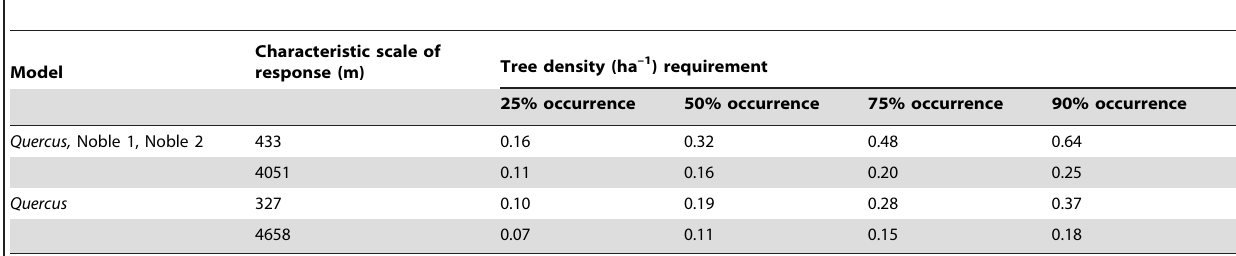
Table 2. Tree density required for 25%, 50% 75% and 90% probability of occurrence of Elater ferrugineus , for two candidate models and for two characteristic scales of response.